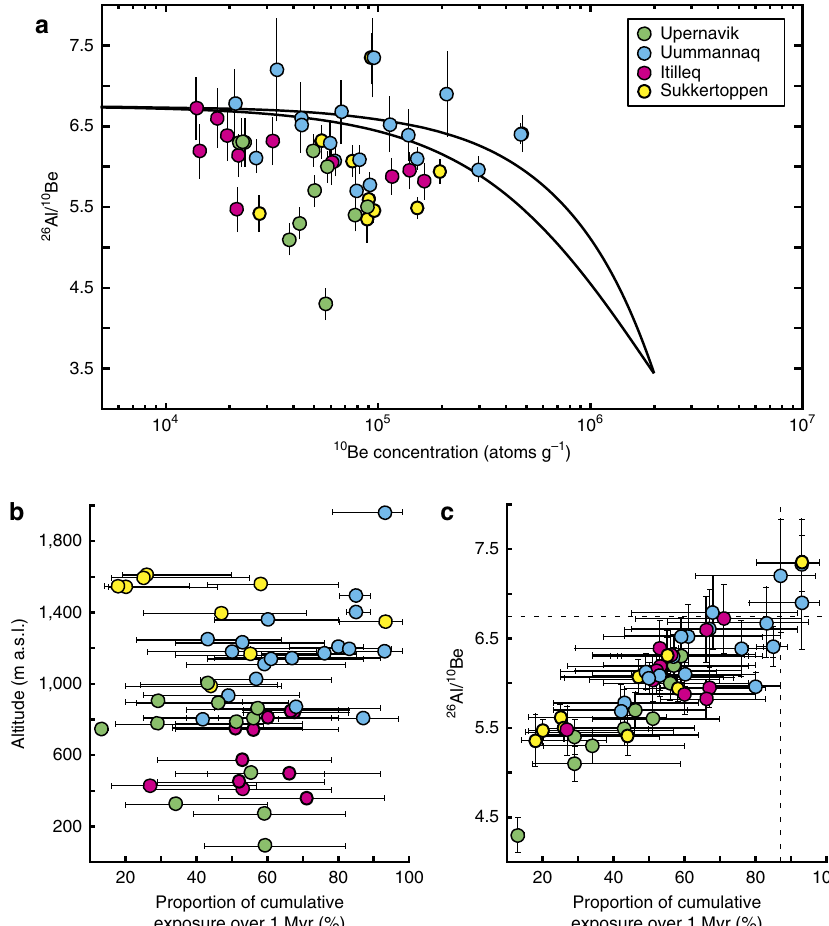
Figure 3 | Linking nuclide concentrations to exposure history. ( a ) Plot of 26 Al/ 10 Be ratio against 10 Be concentration for all samples used in the MCMC- based quantification of complex exposure histories. The upper black line marks the development of the ratio under constant exposure and the lower black line marks the end points of an infinite number of different steady-state erosion rate scenarios with constant exposure. Error bars are based on uncertainties of the 26 Al and 10 Be concentrations. ( b ) Sample altitude plotted against percentage of time exposed over the last 1Myr for each sample. ( c ) Plot of 26 Al/ 10 Be ratio against percentage of time exposed over the last 1 Myr for each sample. There is a clear correlation between 26 Al/ 10 Be ratios and the percentage of exposure over the last 1Myr based on the MCMC-modelled exposure history. The horizontal dashed line marks the production ratio of 26 Al/ 10 Be and the vertical dashed line marks 87% of exposure in 1Myr, which corresponds to 15kyr of ice cover during the LGM. Error bars are defined as the first and third quartiles of the 200,000 iterations per